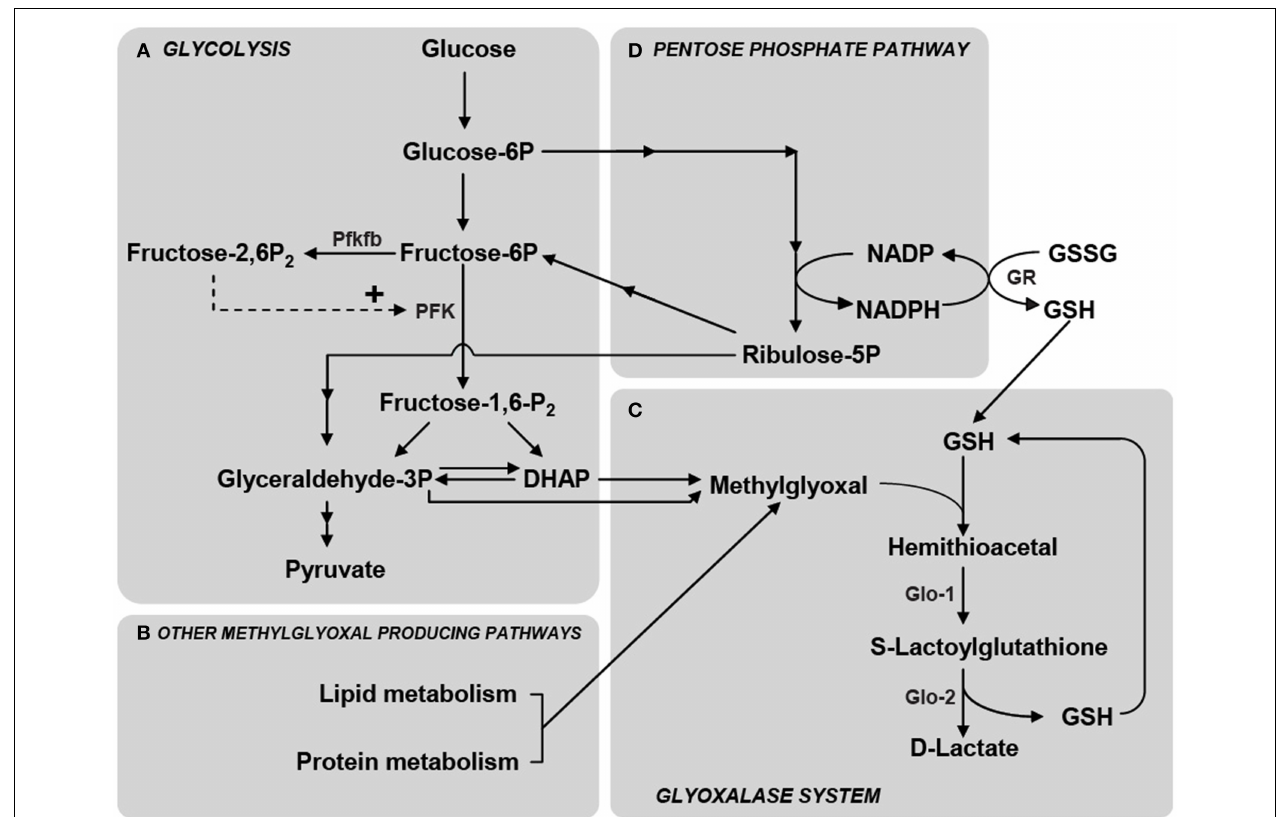
FIGURE 2 | Schematic representation of the main metabolic pathways involved in MG production and elimination. (A) MG is formed mainly by the fragmentation of the glycolytic intermediates glyceraldehyde-3-phosphate (Glyceraldehyde-3P) and dihydroxyacetone phosphate (DHAP), but also from the metabolism of lipids and proteins (B) . Phosphofructokinase-1 (PFK) is the rate-limiting step of glycolysis and thus constitutes an important regulatory site, one of its most potent allosteric activators being Fructose-2, 6-bisphosphate (Fructose-2,6-P 2 ). Fructose-2,6-P 2 levels are controlled by the enzyme 6-phosphofructose-2-kinase/fructose-2,6-bisphosphatase (Pfkfb) which is most abundantly expressed in astrocytes compared to neurons